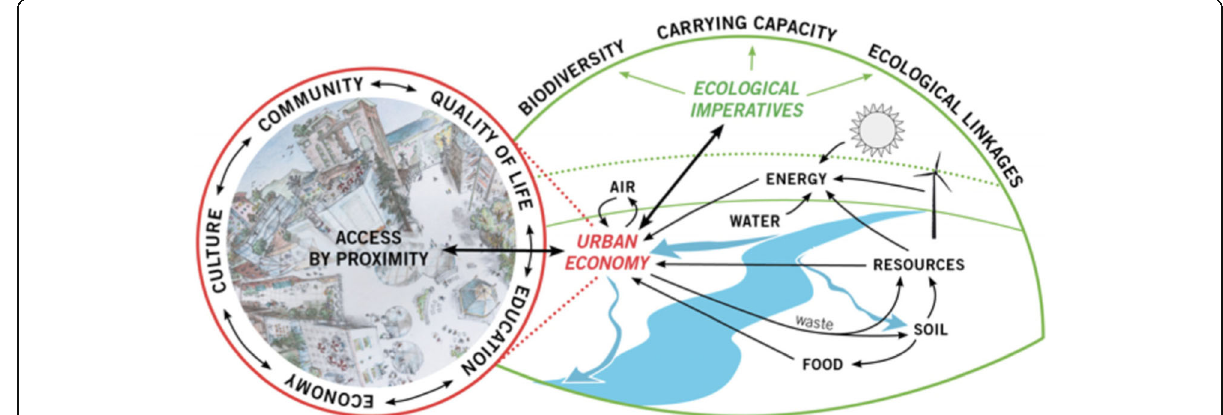
Fig. 3 Cities as interconnected urban ecosystems. Source: IEFS